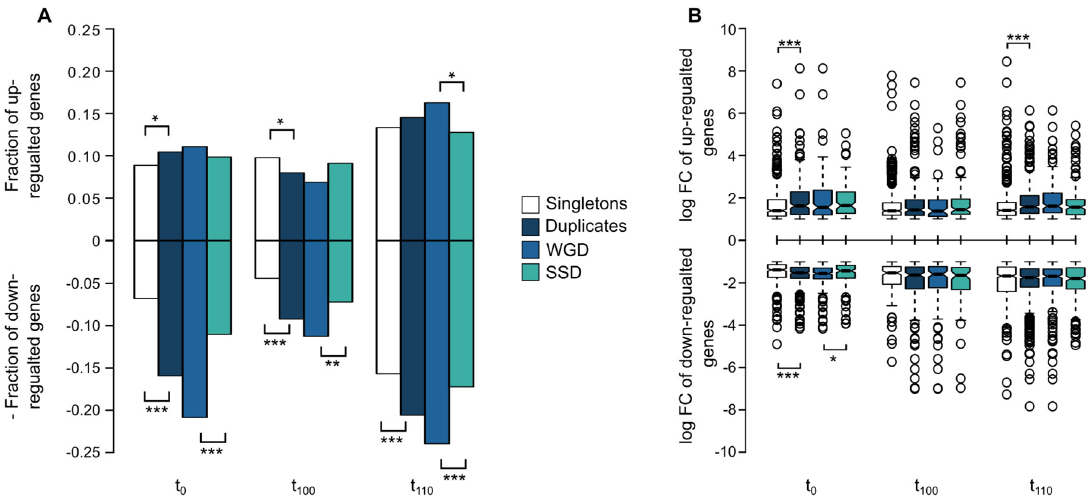
Figure 4. Transcriptional response to lactic acid/lactate in comparison to the response to glucose as the sole carbon source. ( A ) Distribution of fractions of deregulated genes, depending on their classification as singletons or duplicates, and within duplicates, depending on their origin, WGDs (whole-genome duplicates) or SSDs (small-scale duplicates); ( B ) Distribution of expression level as the logarithm of fold-change (log 2 FC) for singletons and duplicates, with duplicates also being divided into WGDs and SSDs. Statistical differences among means were determined with *, ** or ***, corresponding to the probabilities p < 0.05, p < 0.005, and p < 0.001, respectively, using a Wilcoxon rank test.